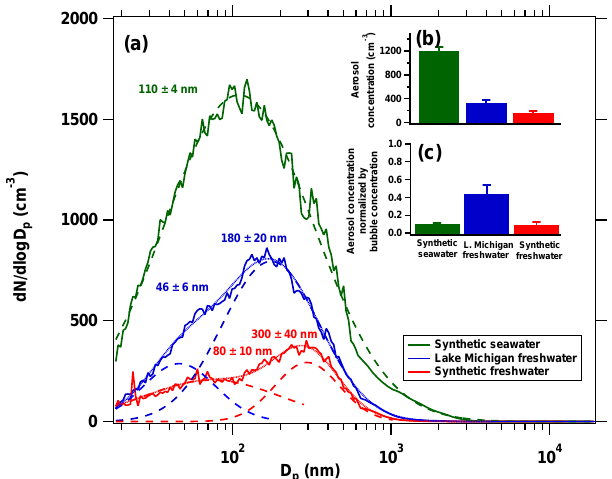
Figure 4. (a) Average aerosol number size distributions fitted with lognormal distributions (long dashes indicate each peak, while short dashes represent the sum of the peaks) (b) average total aerosol number concentration, and (c) average total aerosol number concen- tration normalized by average total bubble concentration produced by the LSA generator (particles per bubble) from synthetic seawa- ter, synthetic freshwater, and Lake Michigan